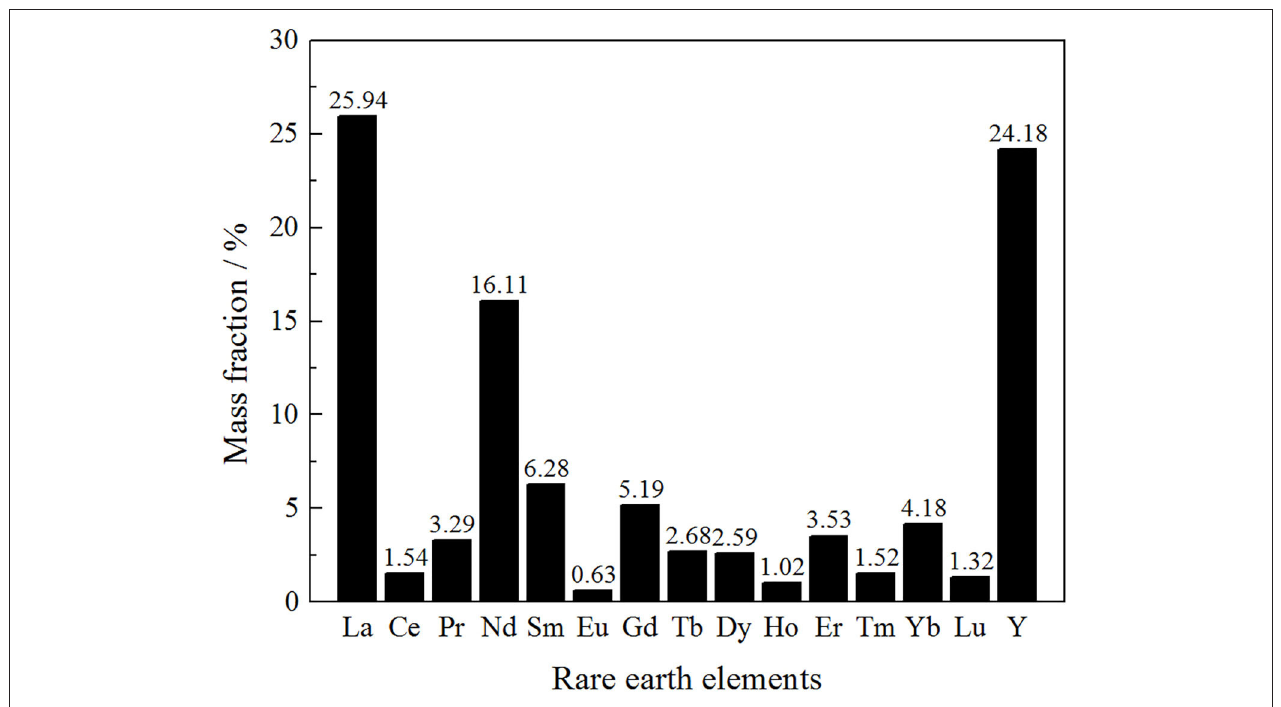
FIGURE 1 | Rare earth elements of the ore